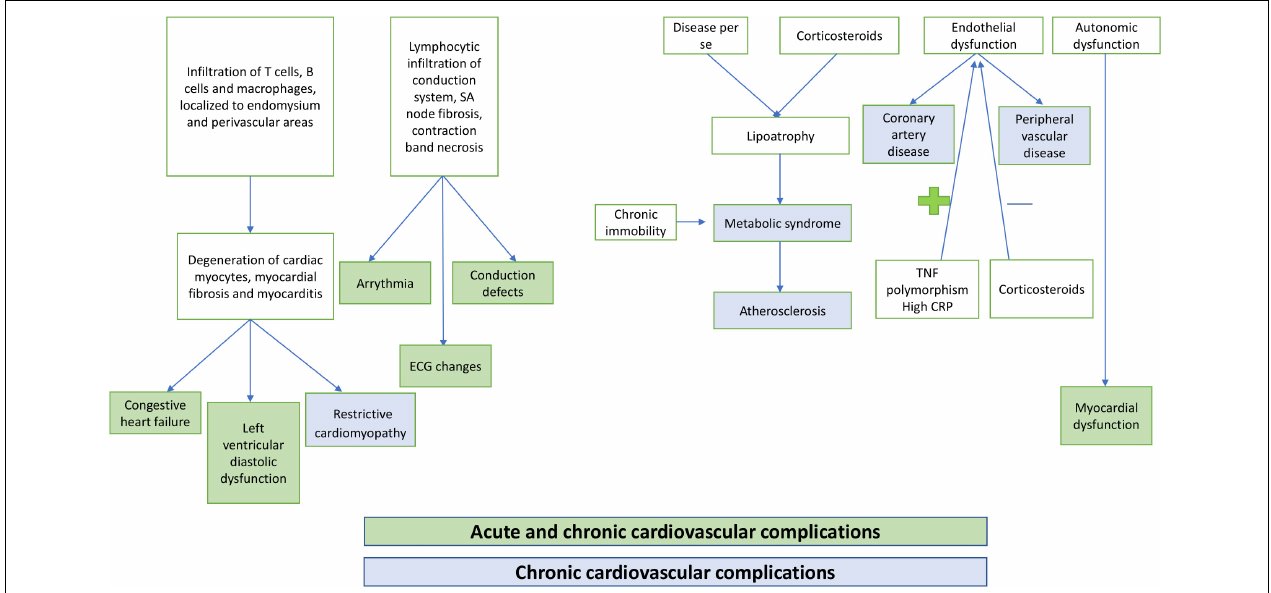
FIGURE 1 | Pathogenesis of cardiovascular complications in children with juvenile dermatomyositis